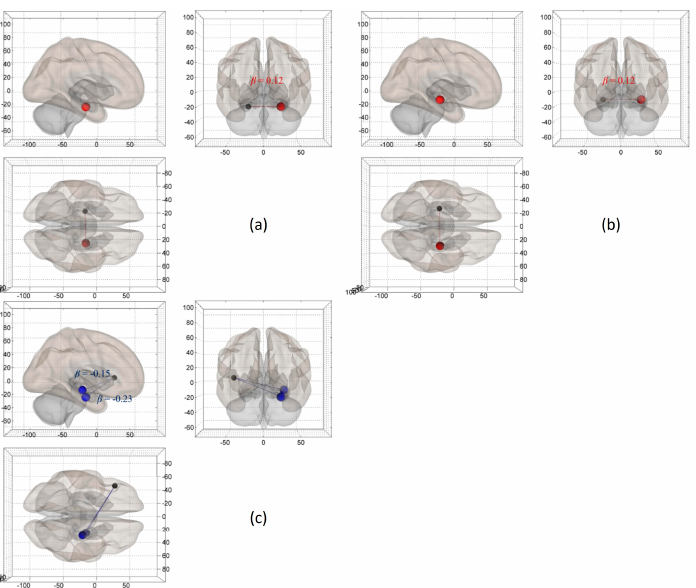
Figure 7. Signi fi cant ROI-to-ROI functional connectivity for relational processing of scenes (N > S contrast), at p < 0.05 ( FDR -corrected), after adjusting for intracranial brain volume and ACC perfor- mance. N: Novel; S: Scrambled . The in-plot descriptions, top left, ( a ) Signi fi cant positive left para- hippocampus-right parahippocampus functional connectivity among older low performers ( n = 6) for relational processing of scenes (N > S contrast); Top right, ( b ) Signi fi cant positive left hippocam- pus-right hippocampus functional connectivity among young performers ( n = 25) for relational pro- cessing of scenes (N > S contrast); Bo tt om, ( c ) Signi fi cant negative left IFG-right hippocampus/para- hippocampus functional connectivity for young versus older low performers ( n = 31) for relational processing of scenes (N > S contrast)